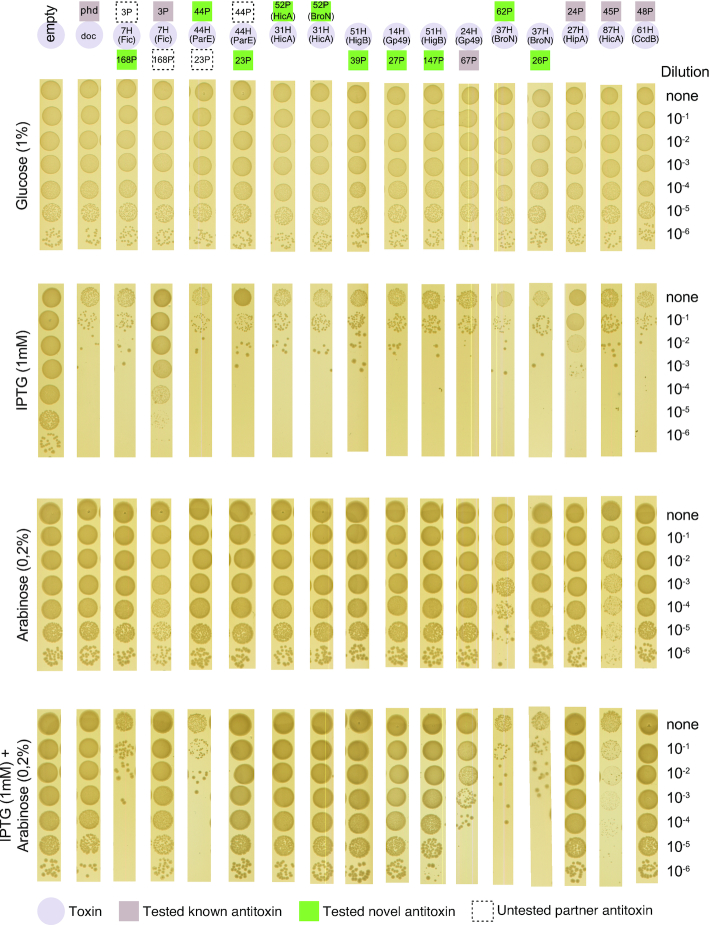
Phenotypic testing predicted TA combinations. Toxins in circles, tested novel antitoxins in green and tested known antitoxins in grey. For operon structures AT1-T-AT2, the untested partner antitoxin is in a dashed square. LB agar plates were supplemented with 1 mM IPTG for the induction of toxin Plac promoters and 0.2% w/v of L-arabinose for the induction of antitoxin Para promoters. Overnight cultures were serially diluted (10−1 to 10−6) in PBS. Figures were cropped from the original images for clarity. Original images available at: https://github.com/ghoresh11/kpneumoniae_TAs/tree/master/results/Functional_validation_orig.